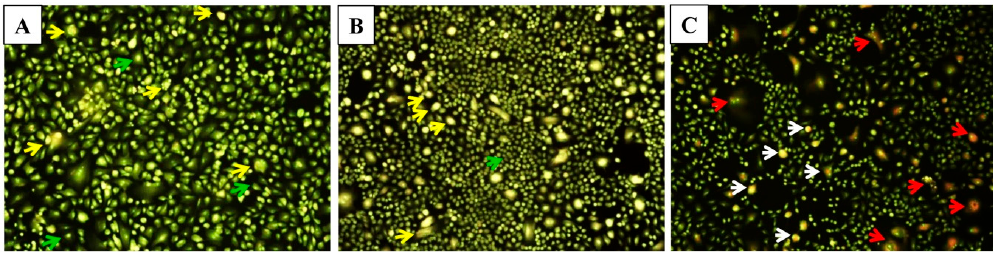
Figure 6. Microscopic images of A549 cells for apoptosis study. ( A ) Untreated A549 cells demonstrated normal structure (green arrows), early apoptosis (yellow arrows) such as chromatin condensation, cell membrane blebbing were observed after treatment with, ( B ) Free EPI ‐ PTX and, late apoptosis (white arrows) and necrosis (red arrows) were noticed after treatment with, and ( C ) PLGA ‐ PEI ‐ EPI ‐ PTX NPs, respectively.